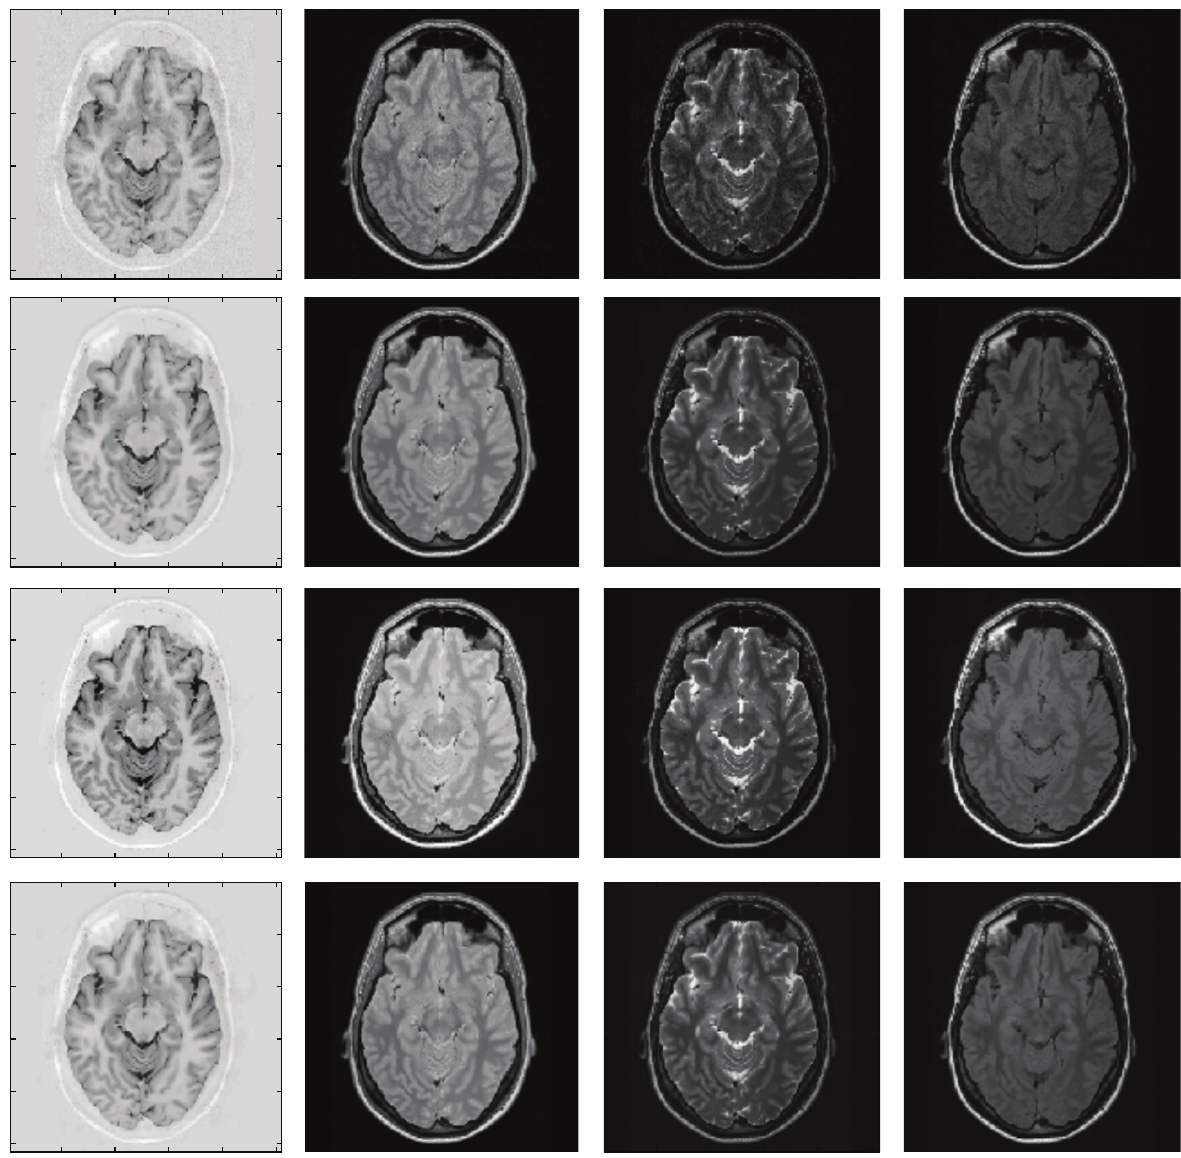
Figure 4: Denoising results (from top to down: original noisy images, denoised images with the OMNLM-PCA, MPVM, and MGMM